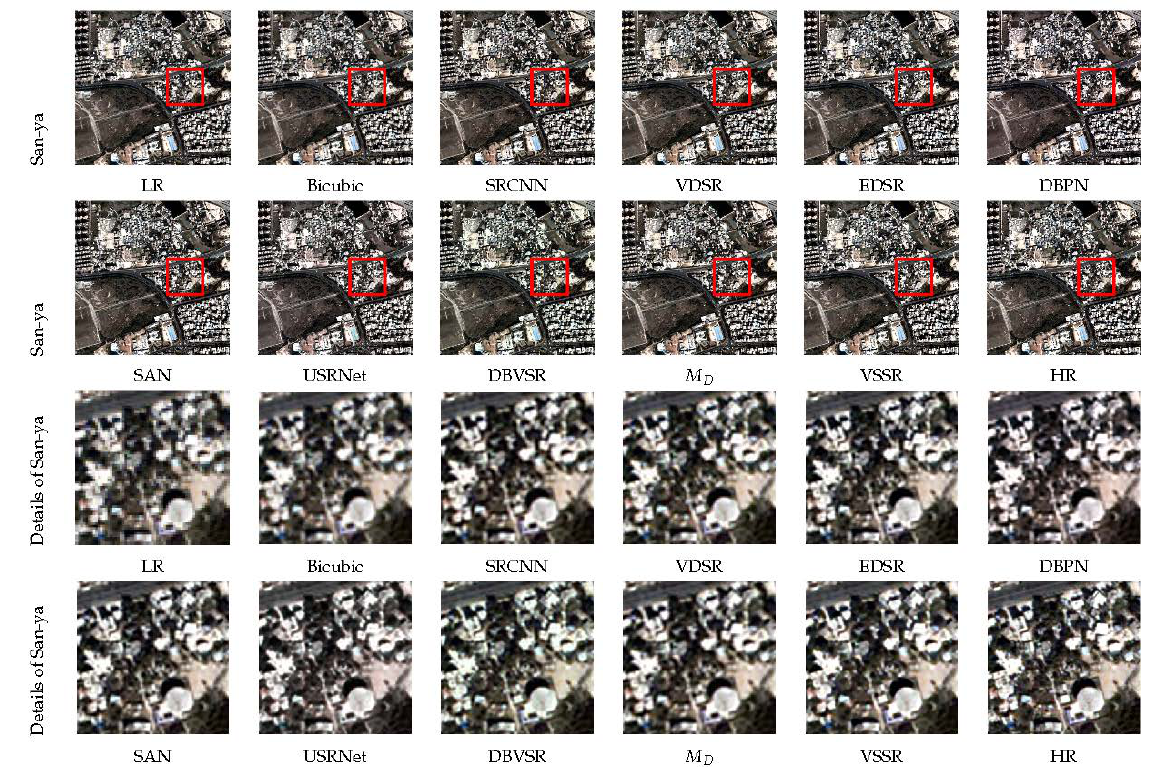
Figure 7. Reconstruction results on the third frame of San-ya (Jilin-1 data) by the scale factor of × 4.